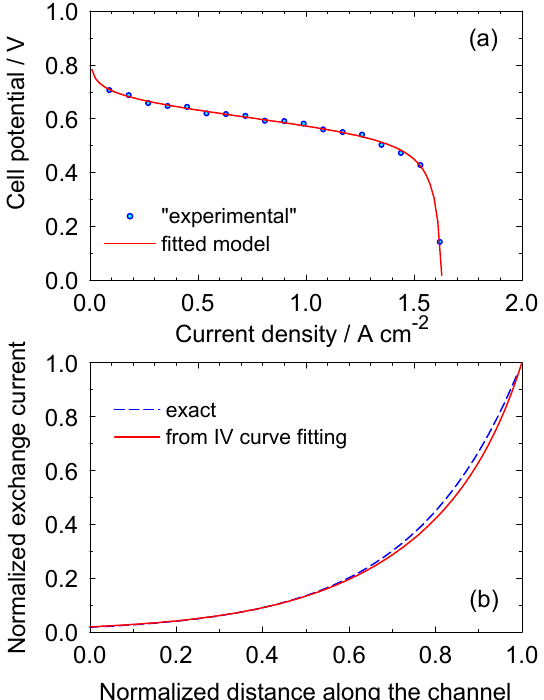
Figure 5. ( a ) Points: perturbed data from the polarization curve in Figure 2b (solid red line). Solid line: the results of the fitting of Equation (16) with model function Equation (23) to the data; ( b ) the exact and resulting from polarization curve fitting shapes of the normalized exchange current density along ˜ z